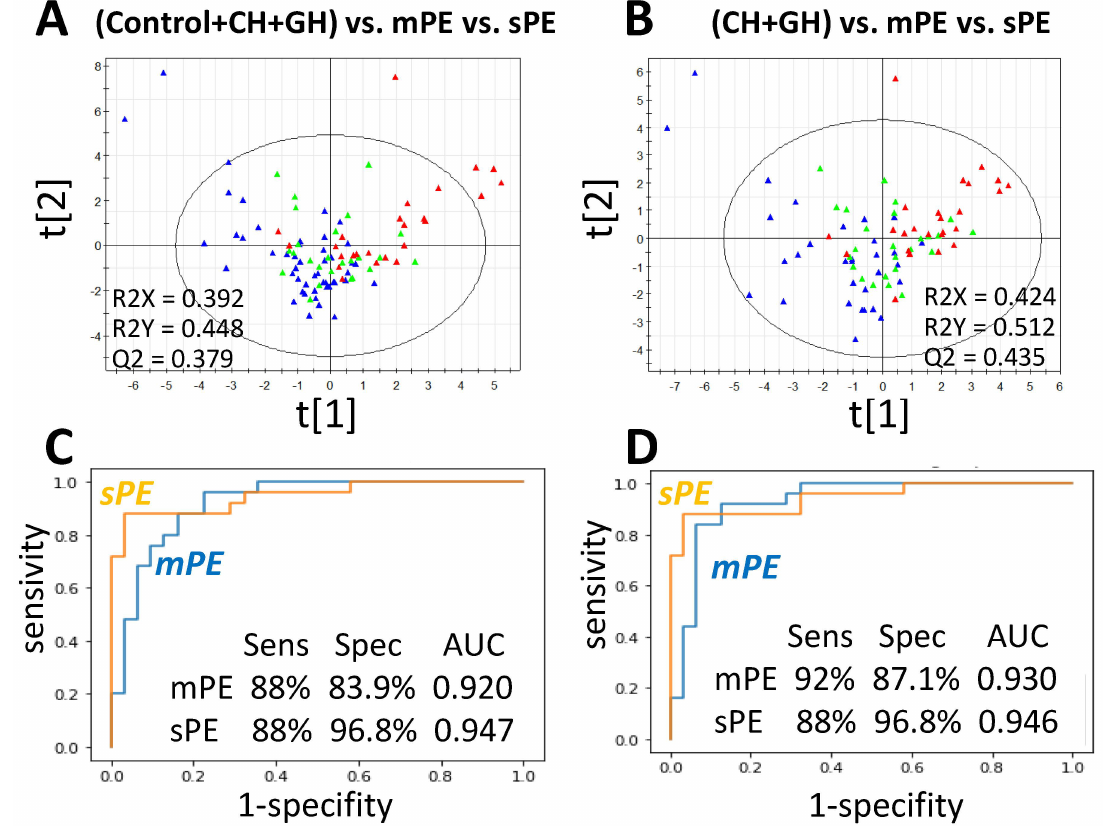
Figure 3. PLS model di ff erentiating mPE and sPE urine samples from control, CH, and GH samples. ( A , B ) PLS score plot of semiquantitative urinary peptidomic data: blue—”Control + CH + GH” ( A ) or ”CH + GH” ( B ); green—mPE; red—sPE. ( C , D ) ROC analysis for mPE or sPE versus ”Control + CH + GH” ( C ) or ”CH + GH” ( D ) according to the results of clustering on 22 and 20 VIP-peptide groups (for C and D ,